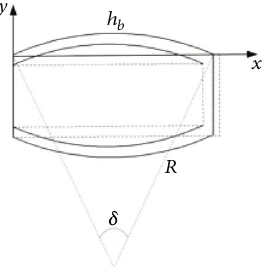
Figure 5: Coordinate system of a single driving cavity